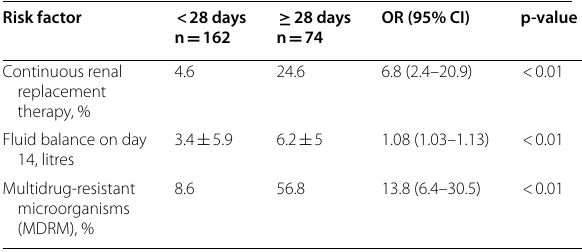
Table 2. Potential modifiable risk factors contributing to ICU